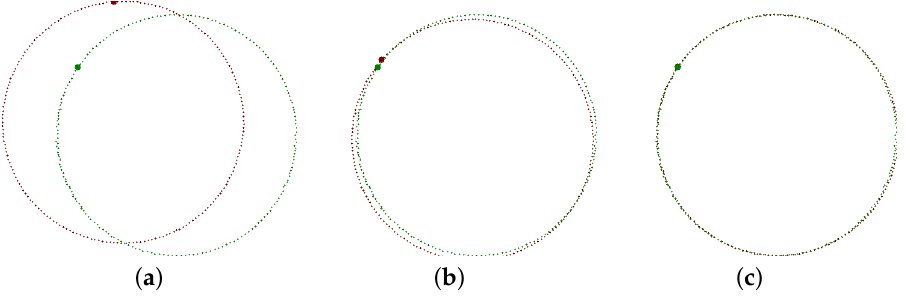
Figure 7. Alignment of 3D contours. ( a ) Inputs to the alignment process; ( b ) the result provided by the Kabsch algorithm; ( c ) the output of our algorithm targeted to contours